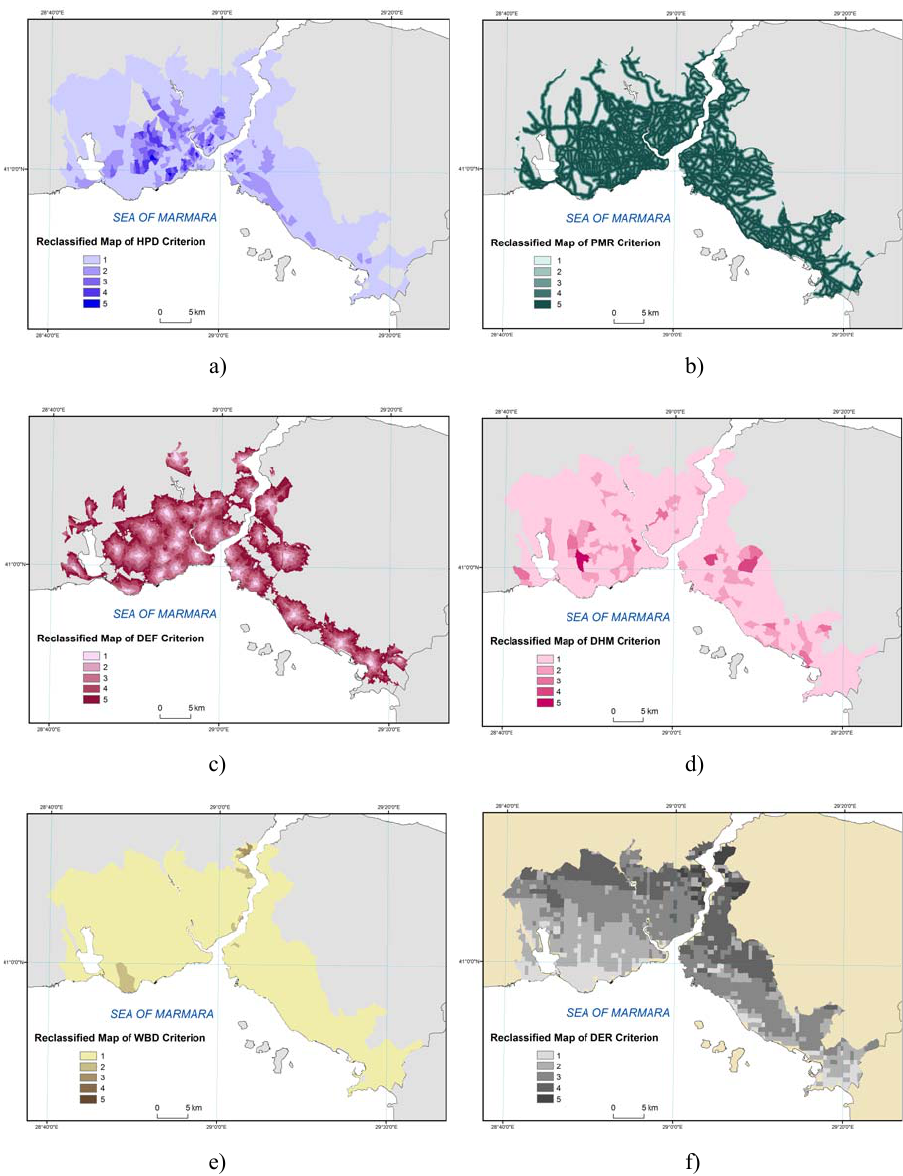
Figure 4. Reclassified Maps of a) HPD, b) PMR, c) DEF, d) DHM, e) WBD, f) DER